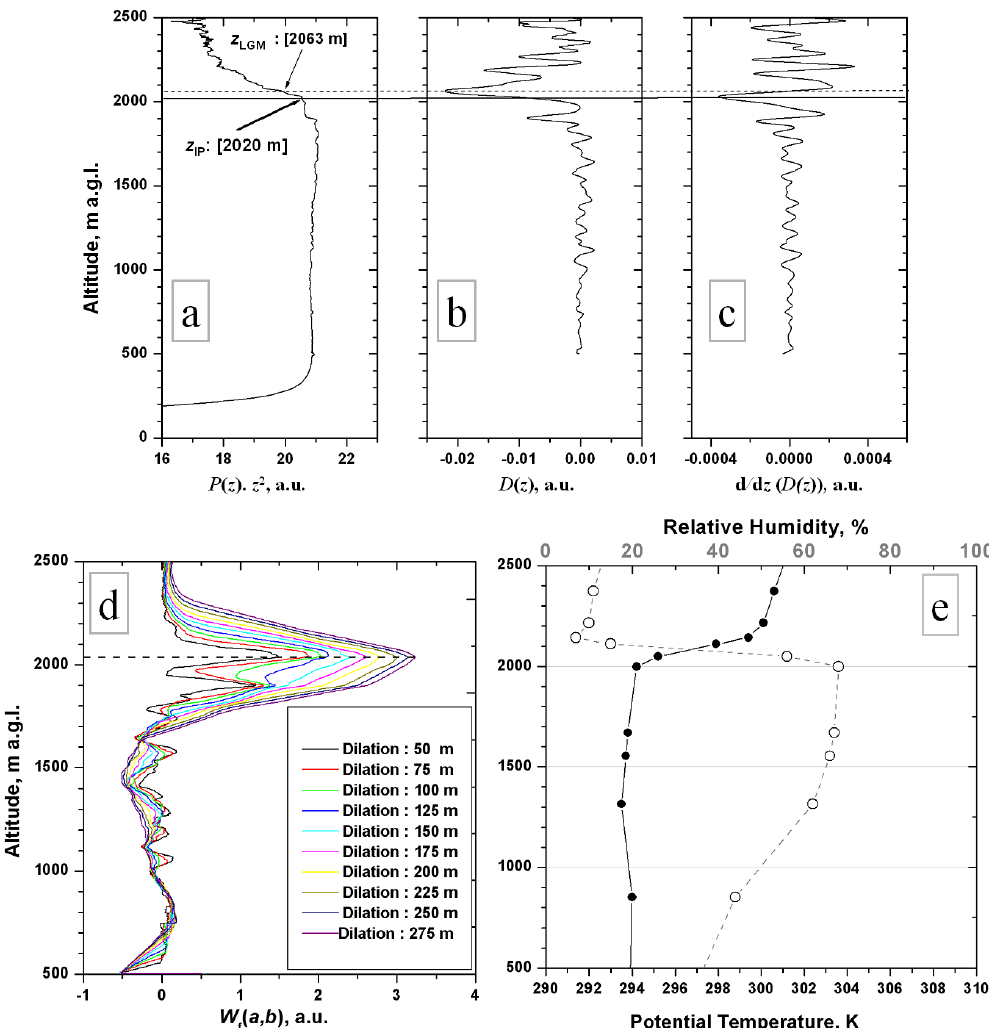
Fig. 3. Determination of the instantaneous height of the CBL on 26 June 2004 at 15:52CEST using LGM, IP method, and HWT-based approach. (a) the background-subtracted range-square corrected backscatter signal, (b) the 1st derivative of its logarithm, (c) the 2nd derivative. The temporal and spatial resolution of the data is 0.33s and 3m, respectively. In height, a 30m gliding average is applied. z LGM and z IP are found at 2063m and 2020m a.g.l., respectively. (d) Wavelet covariance transform W f (a , b) values for different dilations from 50m to 275m. For dilations greater than 175m, W f (a , b) shows a clear maximum at 2030m. (e) Profiles of the potential temperature (bold dots with solid line) and relative humidity (dashed line) obtained from the radiosonde launch at 14:00CEST from Schnarrenberg, Stuttgart (48.8333 ◦ N, 9.2000 ◦ E, 315m a.s.l.) on 26 June